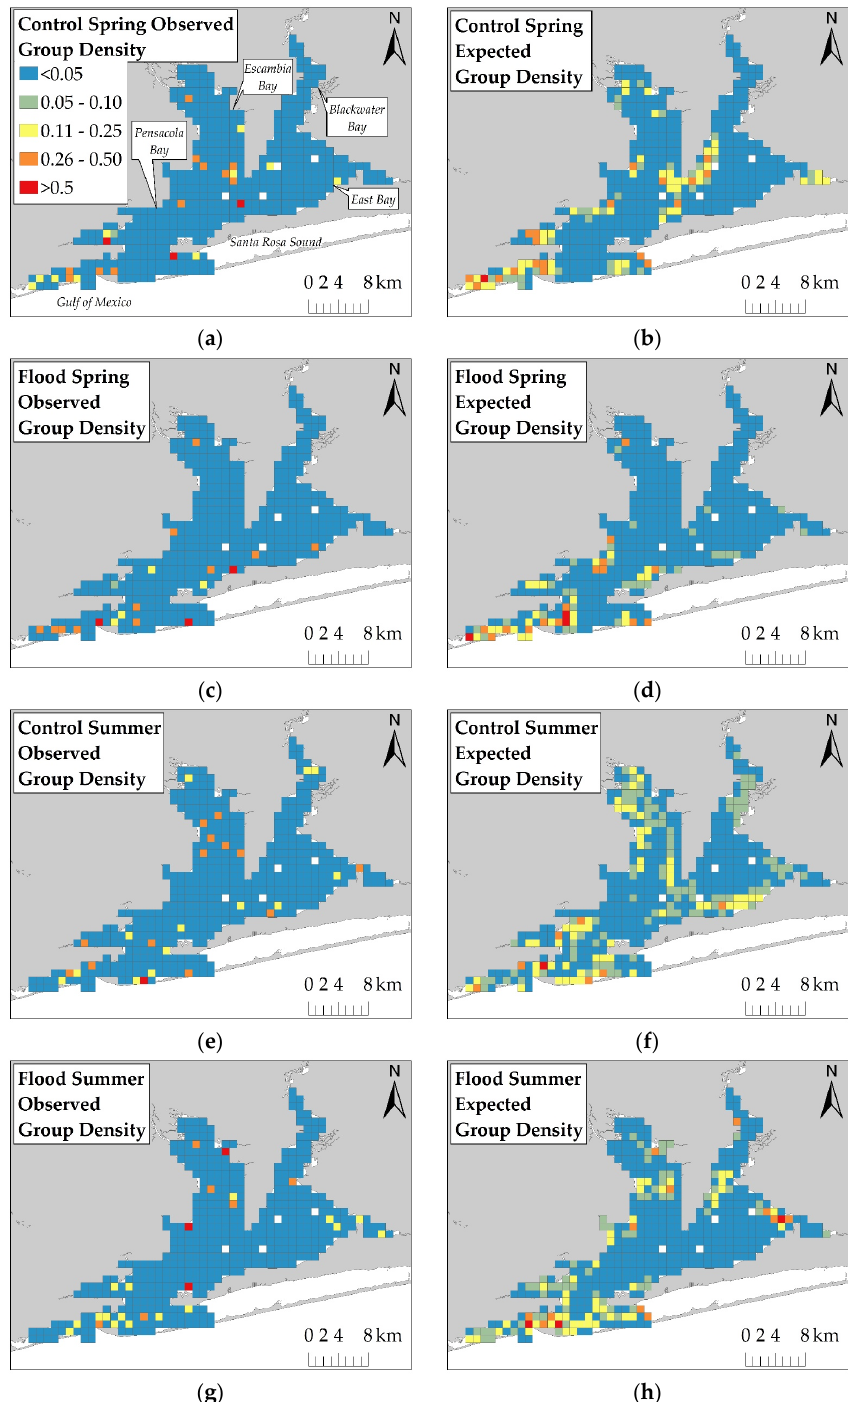
Figure 4. Observed dolphin group density and expected dolphin group density derived from the best fit ZAG model for: ( a , b ) Control Spring; ( c , d ) Flood Spring; ( e , f ) Control Summer; ( g , h ) Flood Summer. Legend in ( a ) applies to all figures. In Control Summer and Flood Summer, dolphins were predicted in southwestern Pen- sacola Bay, northern Pensacola Bay proper, and Escambia and East Bays similar to observed